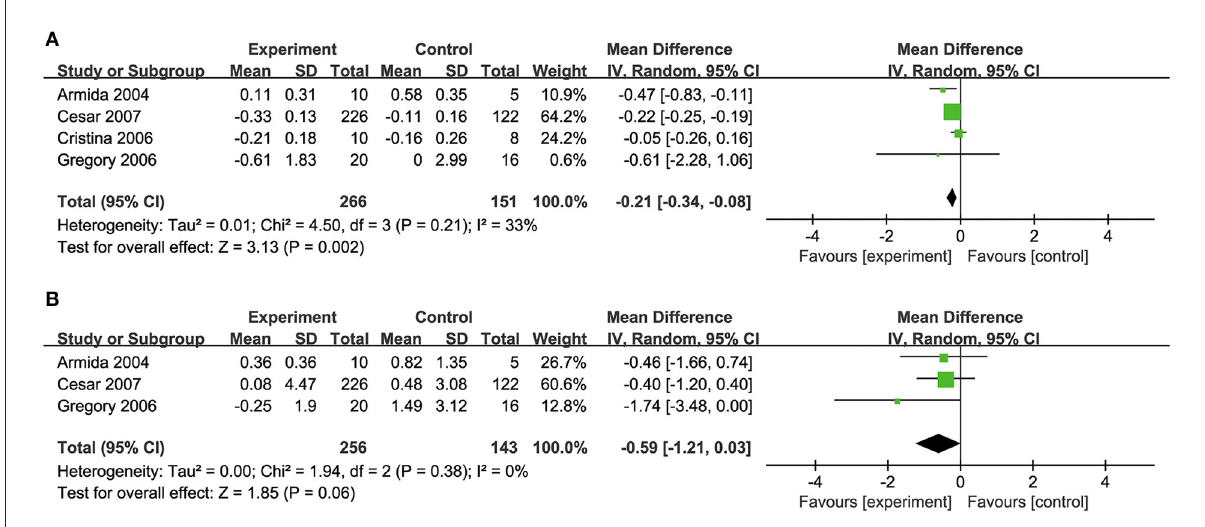
FIGURE5 (A) Effects of biotin supplementation on TC levels. (B) Effects of biotin supplementation on